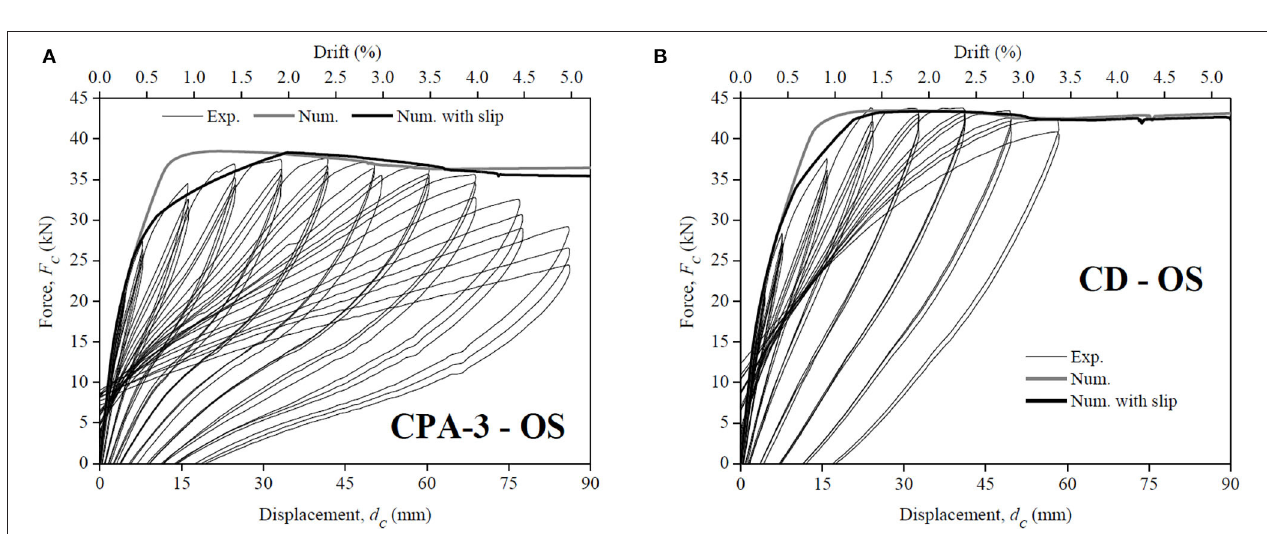
FIGURE 9 | Numerical (with and without slippage) and experimental force-displacement relationships: (A) column CPA-3; and (B) column CD.